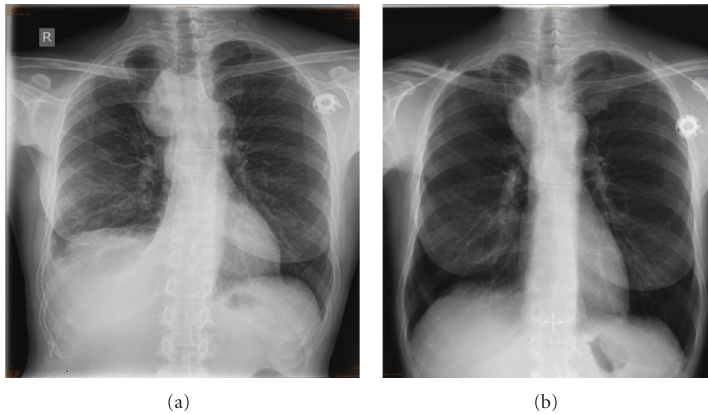
Figure 1: Anteroposterior chest radiograph showing a large homogenous opacity right paramediastinal and right side pleural e ff usion. (a) Initial presentation. (b) Response to treatment with moxifloxacin four weeks after initial presentation.